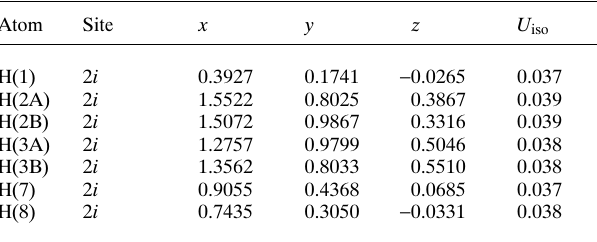
Table 2. Atomic coordinates and displacement parameters (in Å 2 )